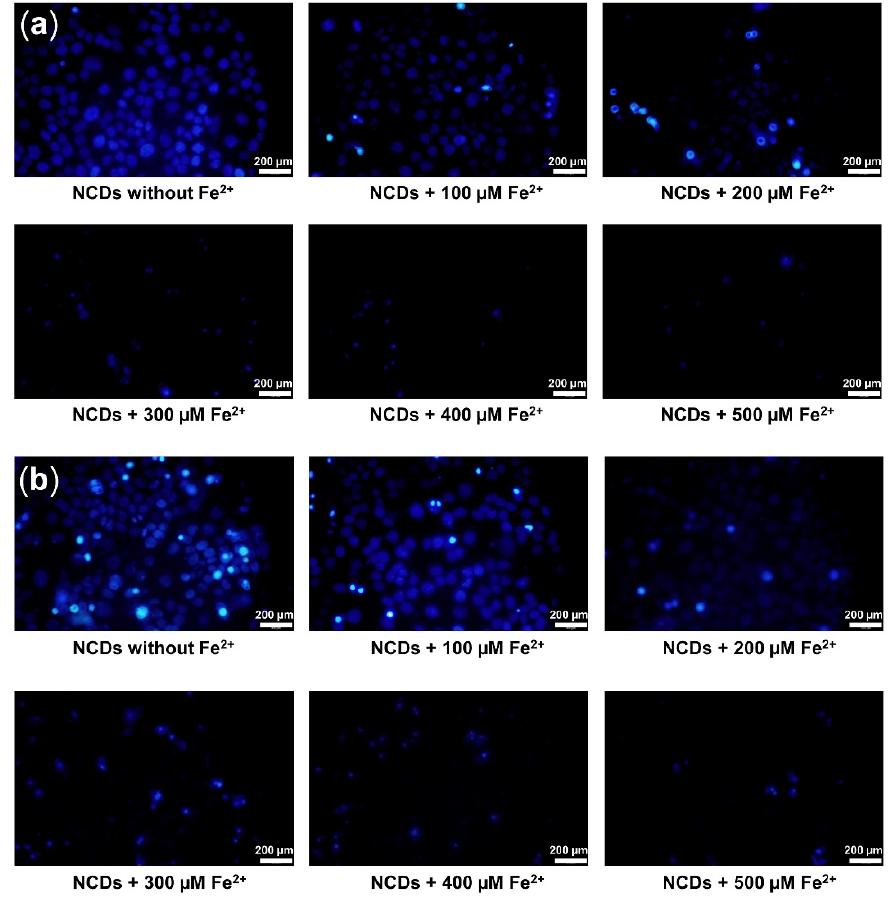
Figure 5. Fluorescent images of NCDs pre-incubated MCF-7 cells ( a ) and HaCaT cells ( b ) after the introduction of different concentrations of Fe 2+ ion for 20 min under 365 nm excitation.